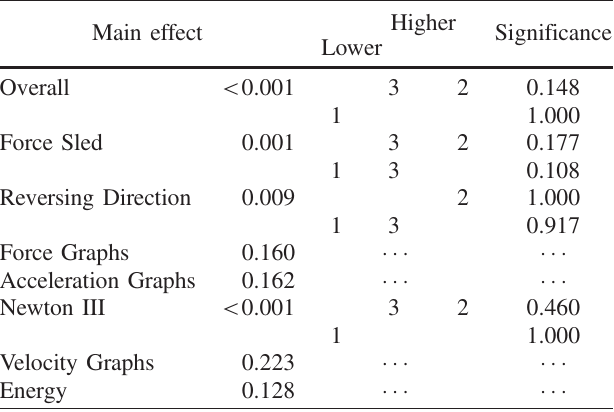
TABLE III. Results from one-way ANOVA and Post hoc comparisons between years at school 1. Numbers reported are p values with the threshold for significance set at p ≤ 0 . 05 . The significance values indicate that statistically significant